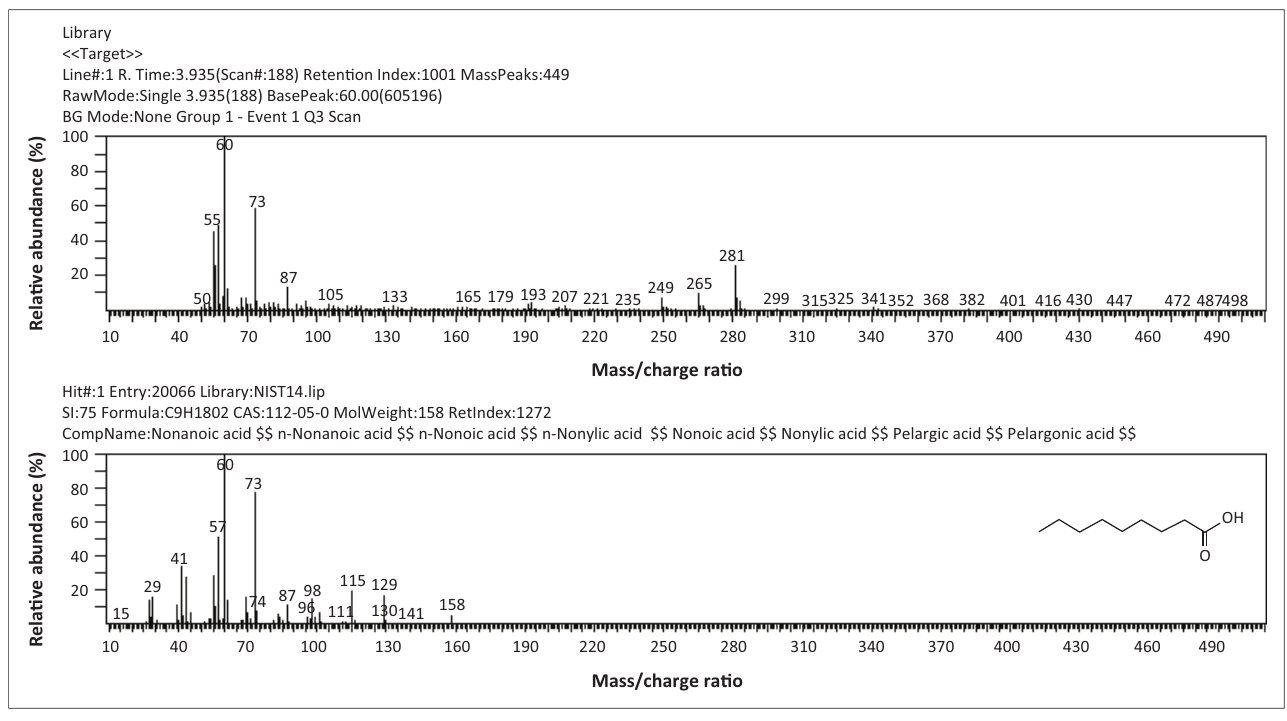
FIGURE 3: Gas chromatography–mass spectrometry spectra of n-nonanoic acid as identified with the help of NIST library.